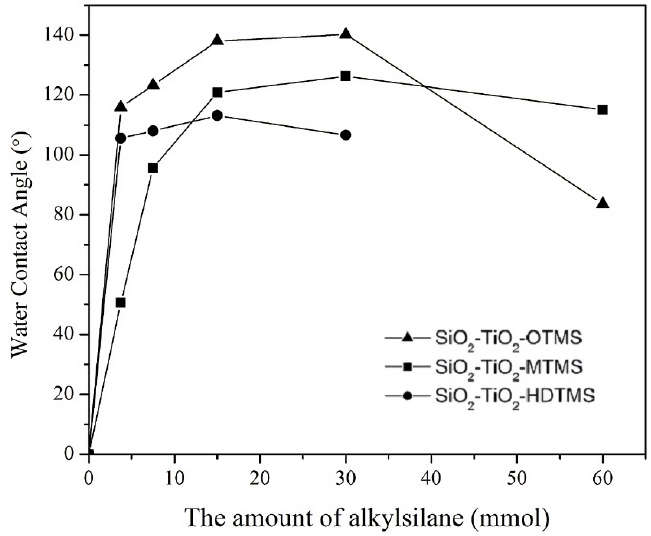
Figure 6. The water contact angle of SiO 2 -TiO 2 -alkylsilane coatings prepared with various compositions of silane.